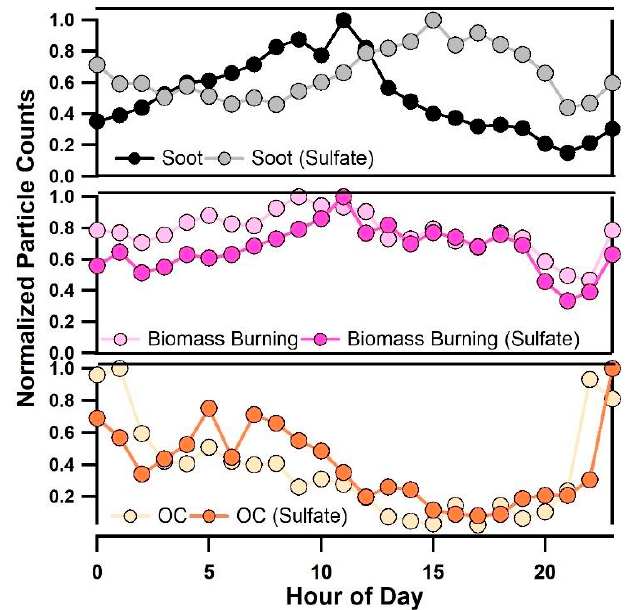
Figure 8. Diurnal profile of soot and soot internally mixed with sulfate ( top panel ), biomass burning and biomass burning aerosol internally mixed with sulfate ( middle panel ), and OC and OC internally mixed with sulfate ( bottom panel ).